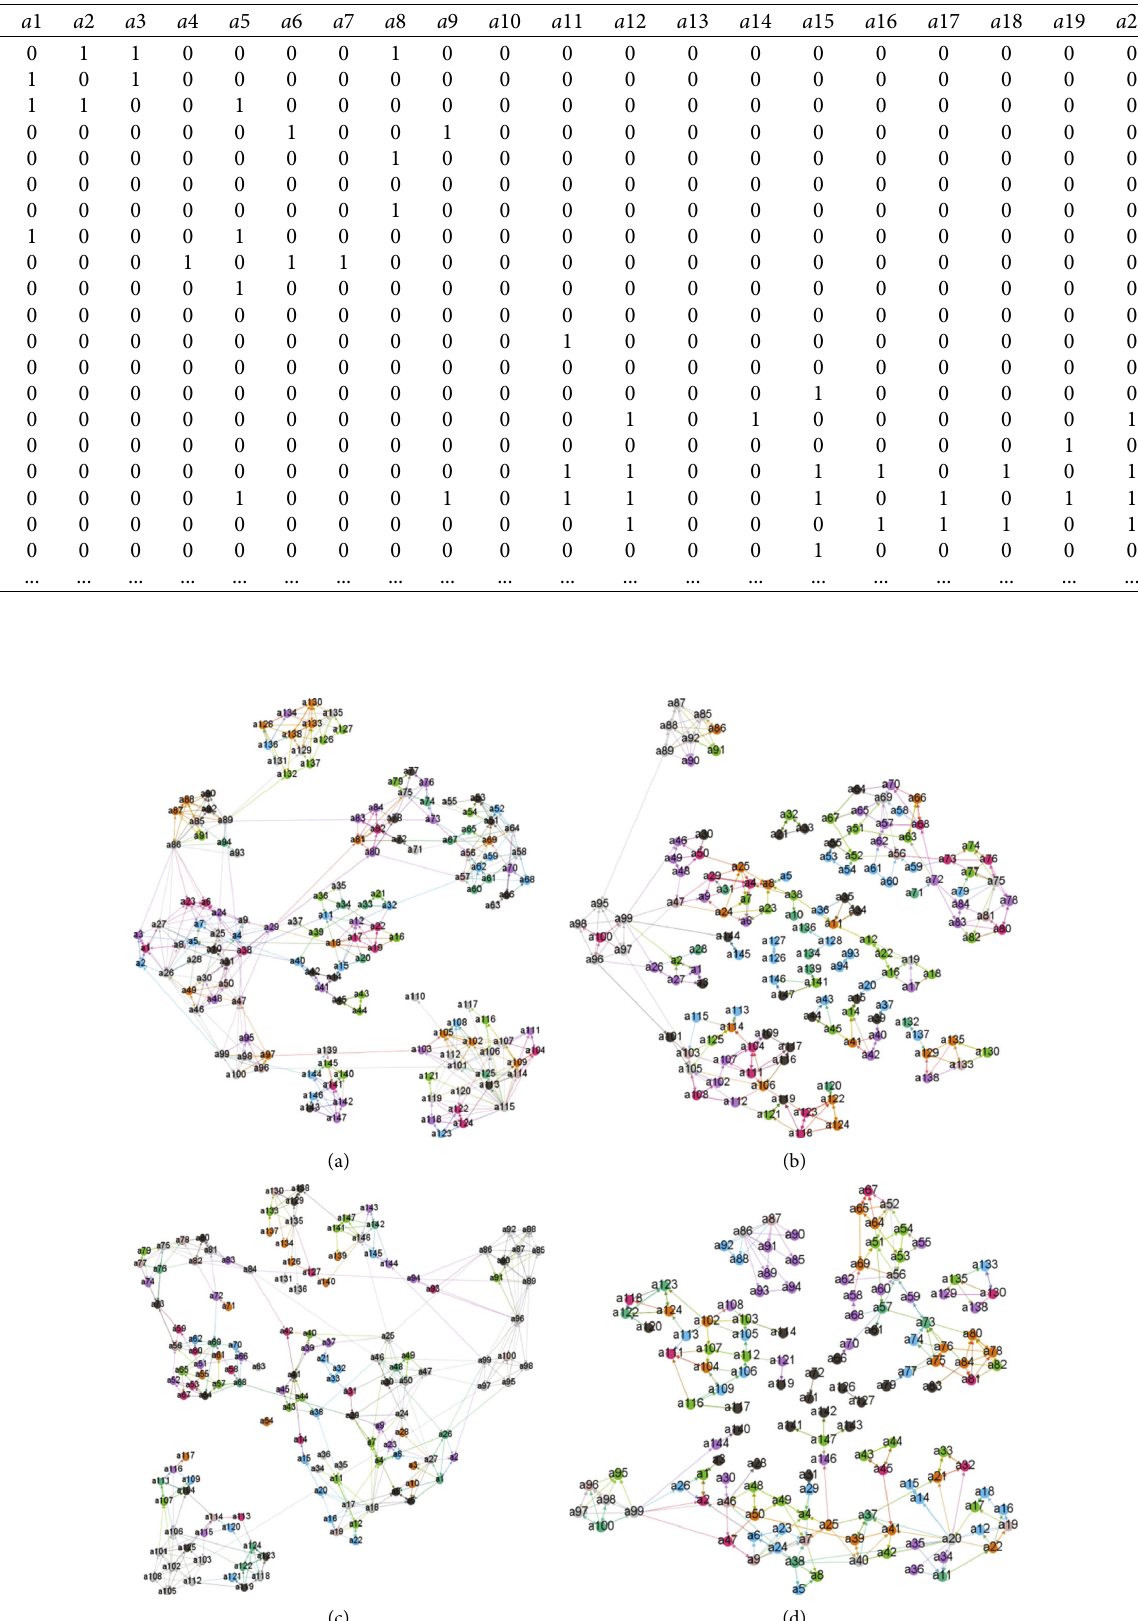
Table 1: Athlete online relationship